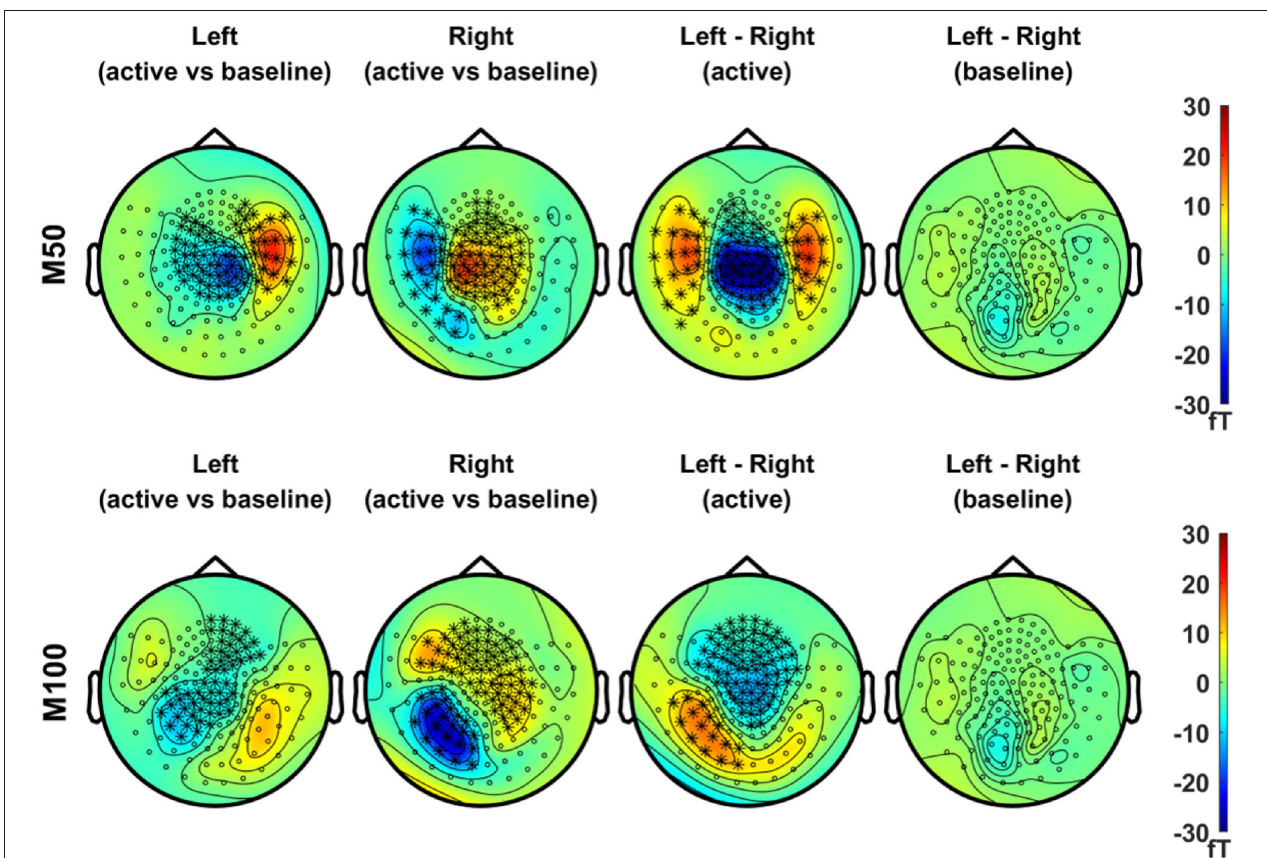
FIGURE 3 | Topographical maps of peak MEG responses to vibrotactile stimulation. In the upper panel, field distributions of the grand averaged M50 responses (mean values of ERFs over an active period between 46 and 66 ms) after left (first column) and right (second column) index finger stimulation were statistically compared with their respective baseline level, separately ( N = 29, cluster-based permutation test, 1,000 runs, cluster-defining threshold p < 0.05, α = 0.05). In addition, the difference in M50 between left and right stimulation conditions, as well as the difference in baseline activity between conditions, was statistically tested for significance ( N = 29, cluster-based permutation test, 1,000 runs, cluster-defining threshold p < 0.05, α = 0.05). Channels associated with significant clusters are indicated by asterisks. In the lower panel, the same analyses were applied as the upper panel but with M100 responses (mean values of ERFs over an active period between 90 and 110 ms). All plots are obtained for axial